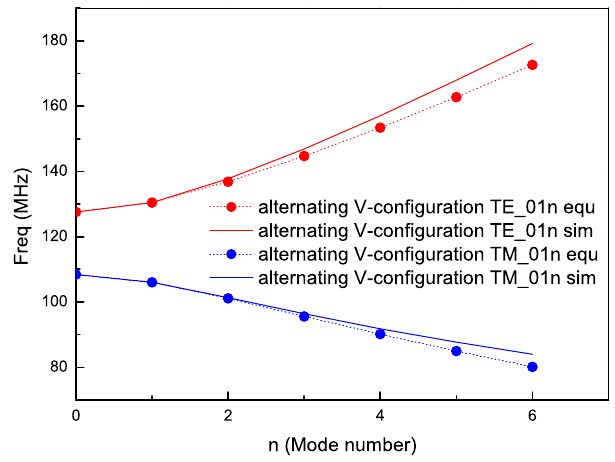
FIG. 8. Dispersion curves of stems with cross and alternating V-configuration. Solid lines are from simulations and circles are from Eq. (19).